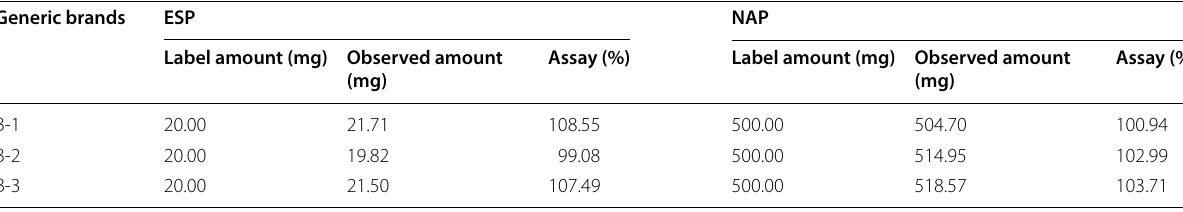
Table 10 Determination of ESP and NAP in marketed